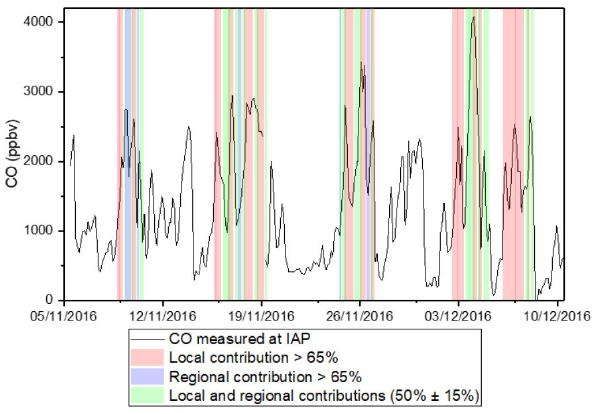
Figure 11. Time series of the measured CO at the IAP in the winter APHH campaign, during the five haze events where PM 2 . 5 concen- tration was over 75µgm − 3 . The colours represent the three classifi- cations observed during the five haze episodes identified in Shi et al.